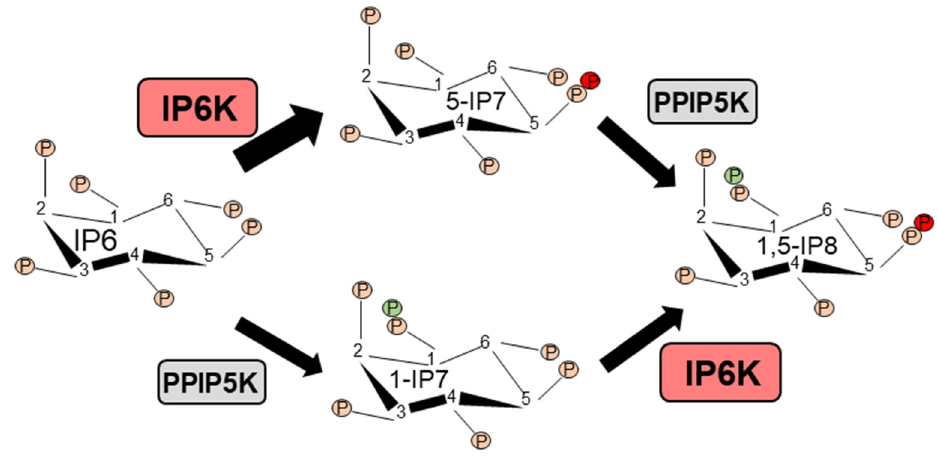
Figure 1. IP6Ks generate 5-IP7 from IP6. PPIP5Ks synthesize 1,5-IP8 from 5-IP7. The right panel shows the alternate route of the synthesis of 1,5-IP8. Left panel. 5-IP7 is the most abundant and characterized inositol pyrophosphate in mammals.